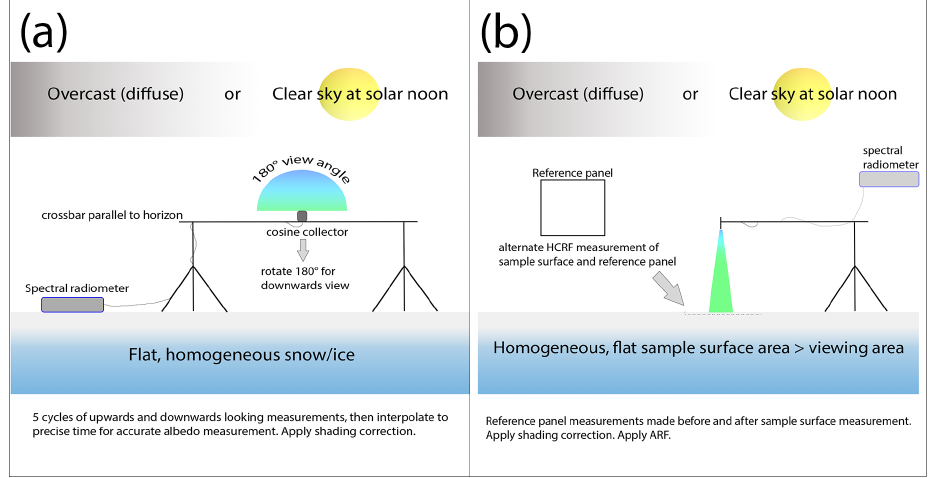
Figure 5. Schematic diagram of albedo measurement configurations for (a) a cosine collector and (b) HCRF measurement